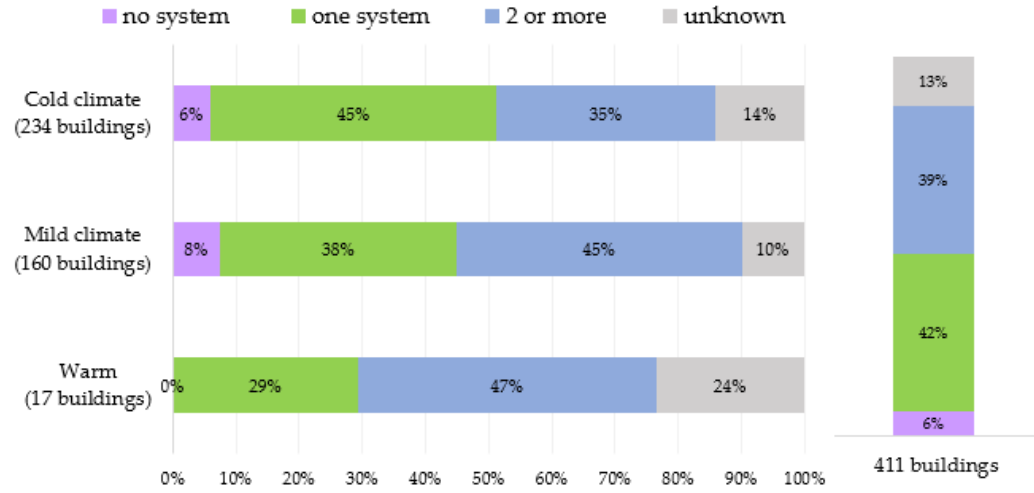
Figure 25. Share of renewable energy systems installed (heat pumps, PV and ST) in the nZEBs analyzed.